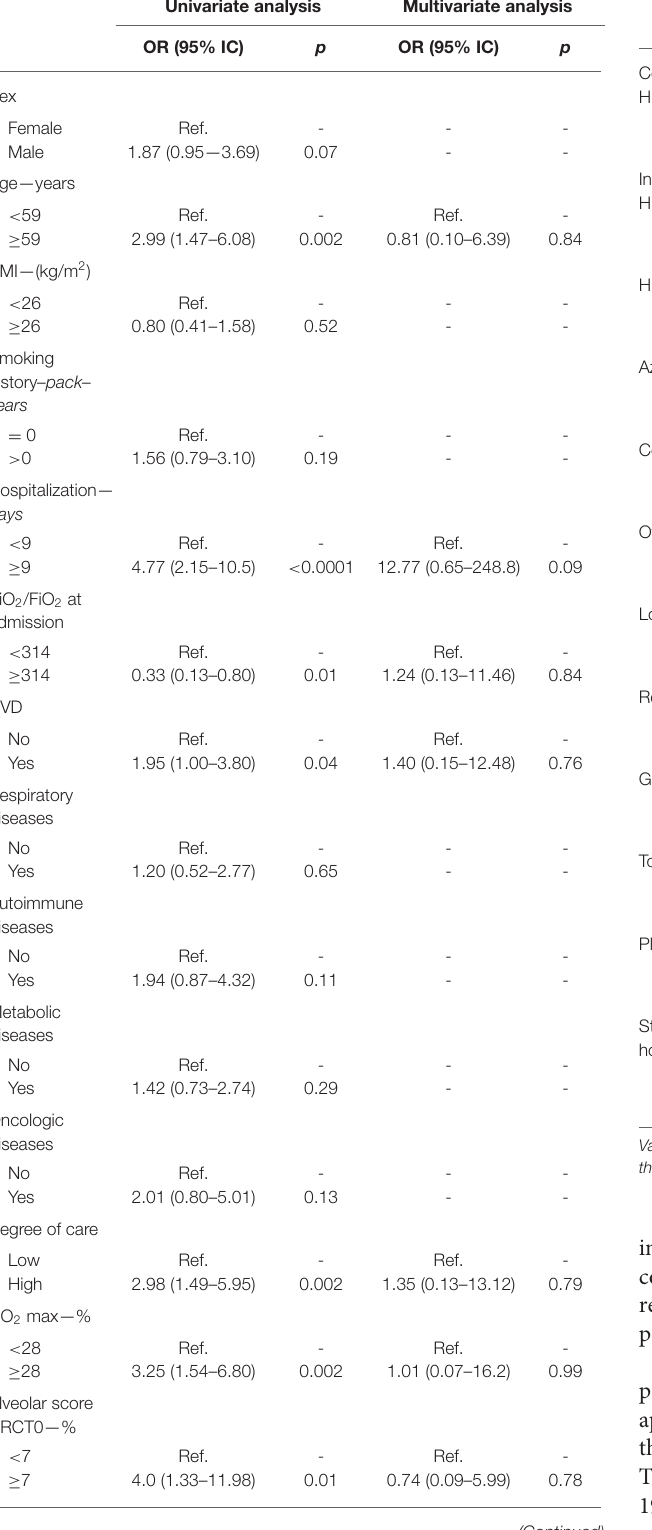
TABLE 3 | Predictive factors of radiological sequelae at follow-up in patients hospitalized for SARS-COV-2-related pneumonia. Univariate analysis Multivariate